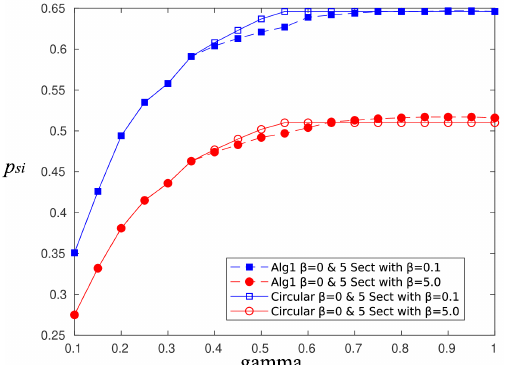
Figure 15. Probability of successful information reception, p si , Algorithm 1 vs. circular selection of